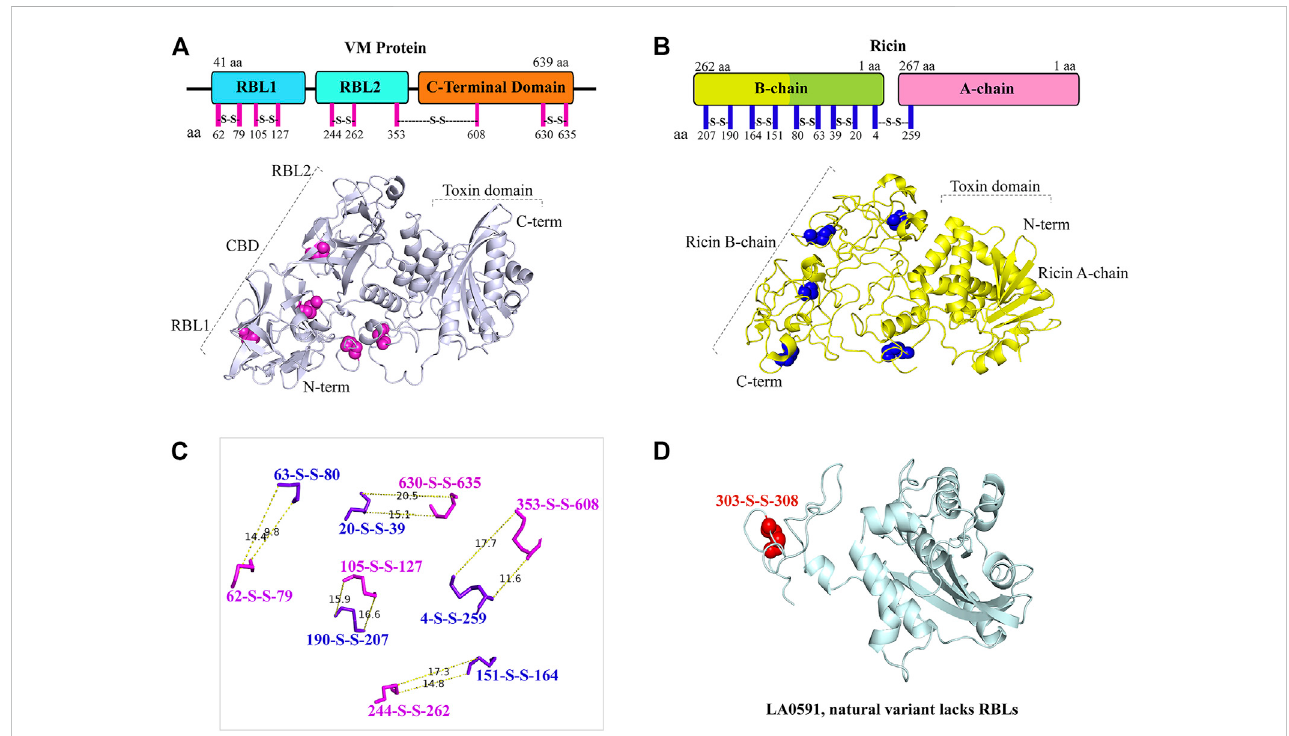
FIGURE 4 Representation and similarly of disul fi de bond in LA3490 VM protein and in ricin toxin. (A) Schematic diagram shows the amino acid position of fi ve disul fi de bonds (magenta lines) in the VM protein domains. AlphaFold algorithm generated 3D cartoon structure of LA3490 (light blue color) showing fi ve disul fi de bonds (magenta spheres) by pairing 10 cysteine residues. (B) Ricin toxin (PDB: 2AAI) showing fi ve disul fi de bonds by pairing 10 cysteine residues in both schematic diagram (blue lines) and 3D-structure (blue spheres) respectively. (C) Measurement wizards were used to measure the distance of disul fi debondbetweenVM proteinand ricin usingPyMOL 2.4.0. (https://pymol.org/2/). The dottedlines displayed the distance inAngstroms. (D) Presence of a single disul fi de bond (red spheres) in LA0591 shown at positions